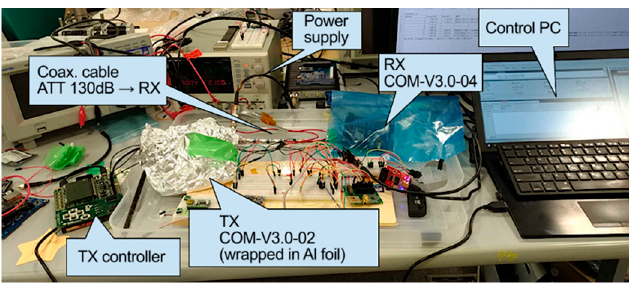
Figure 12. Frequency shift tolerance test equipment.